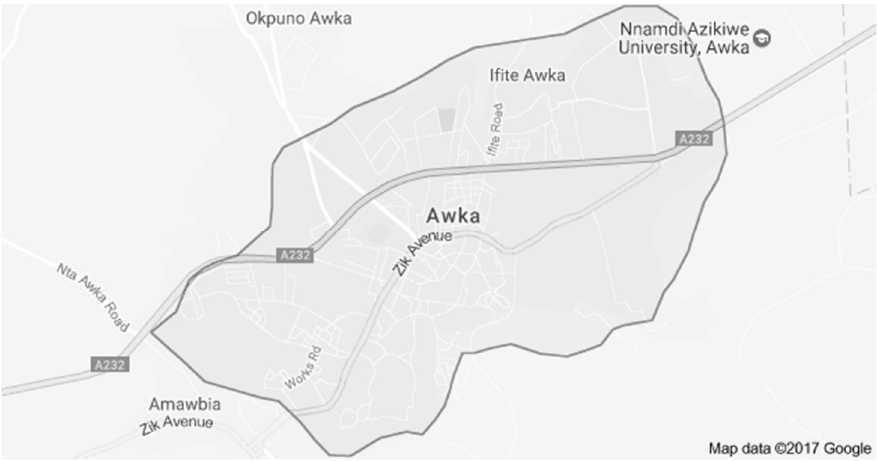
Figure 1. Showing the location of popular Nnamdi Azikiwe (Zik’s) Avenue.